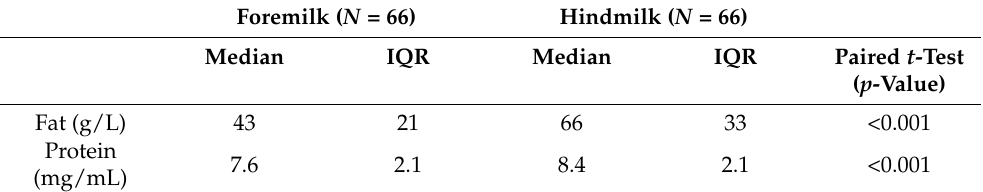
Table 7. Difference in protein and fat contents between fore- and